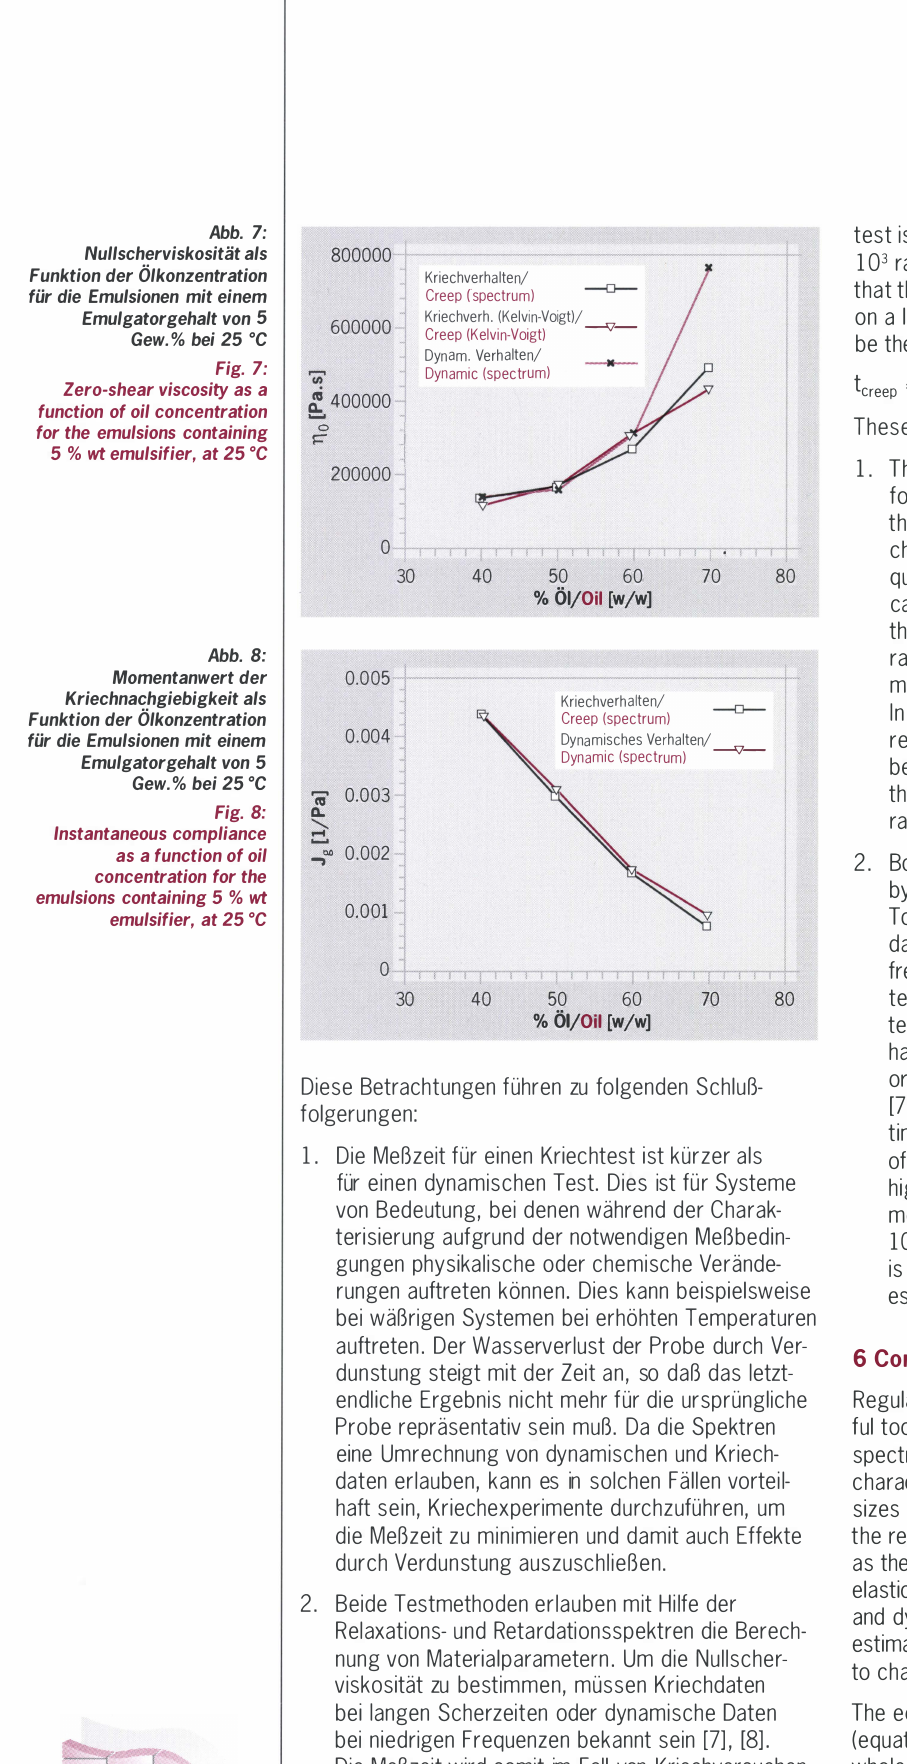
Fig. 7: Zero-shear viscosity as a function of oil concentration for the emulsions containing 5 % wt emulsifier, at 25 oc